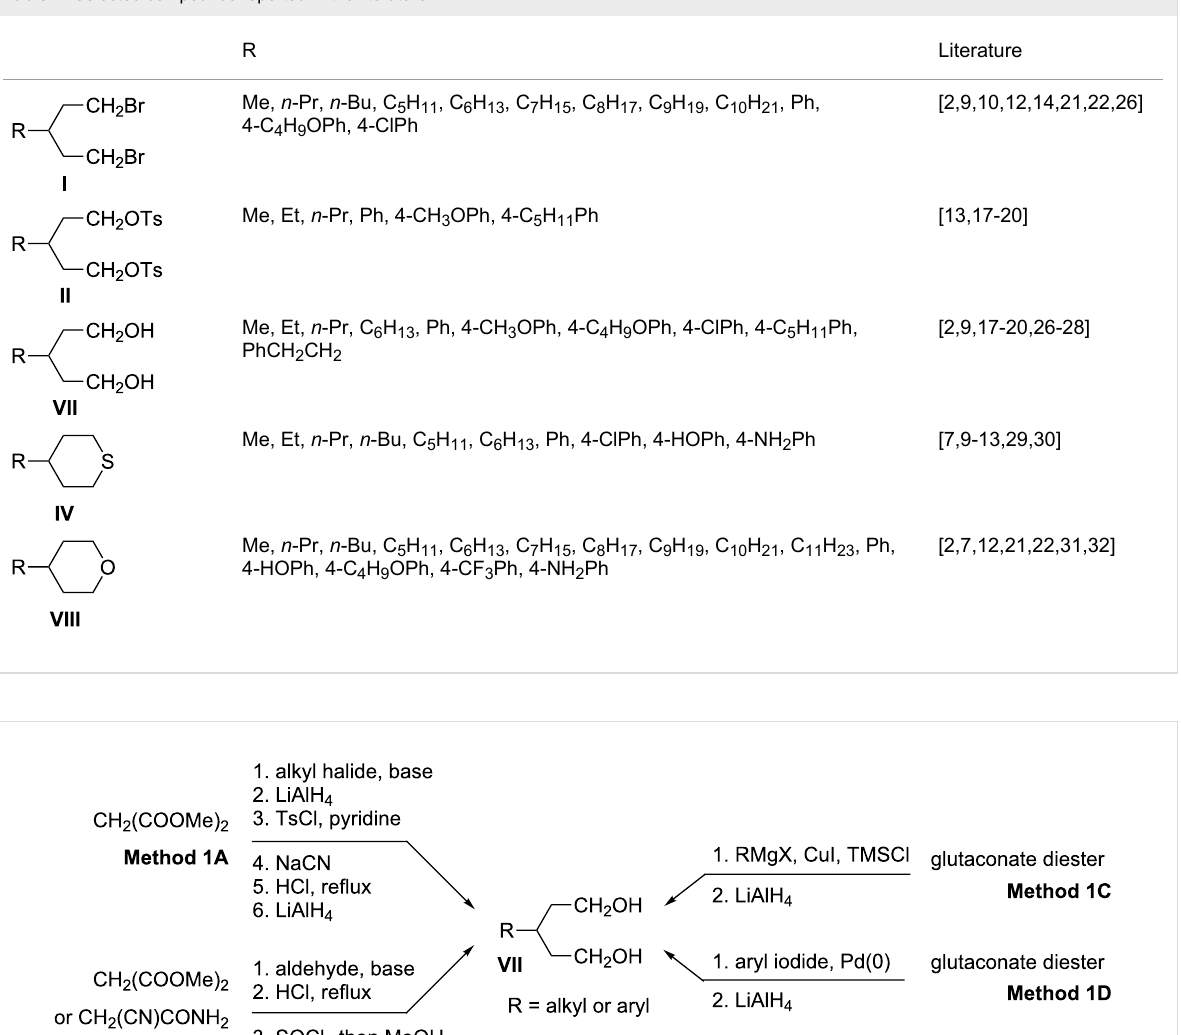
Table 1: Selected compounds reported in the literature.